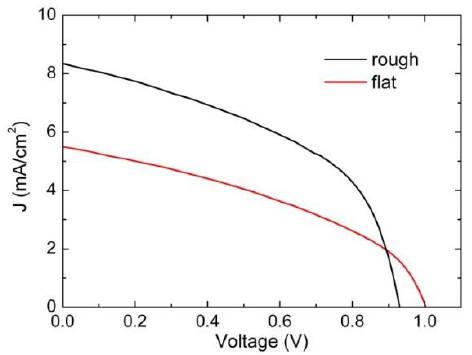
Figure 4. J-V characteristic under AM1.5 illumination for the same a-SiO x :H solar cell grown at 28 mW/cm 2 with CO 2 = 3 sccm and H 2 = 120 sccm on commercial rough substrate (black line) and on in-house flat ZnO:Al on glass (red line).